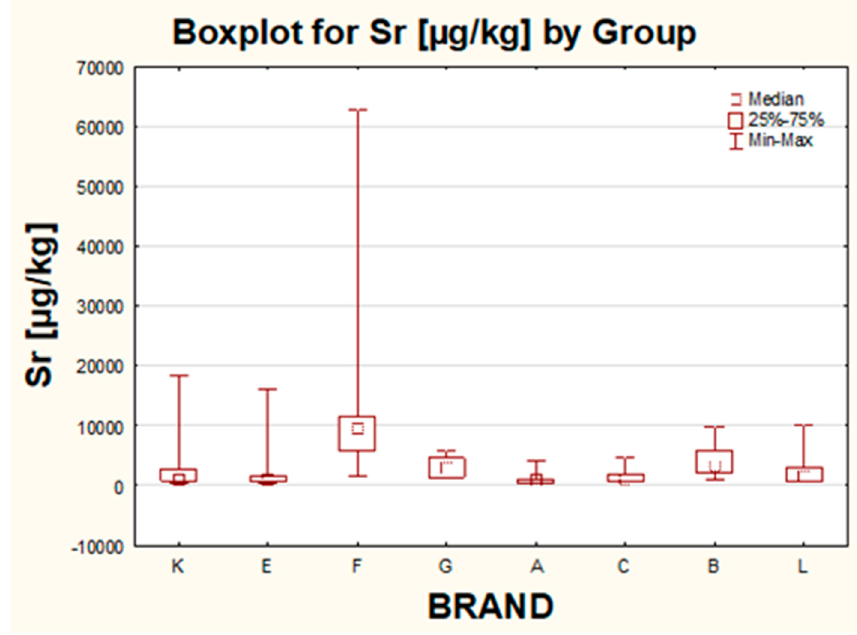
Figure 5. The box–whisker plots representing the influence of the company on the concentrations of Sr (µg/kg).